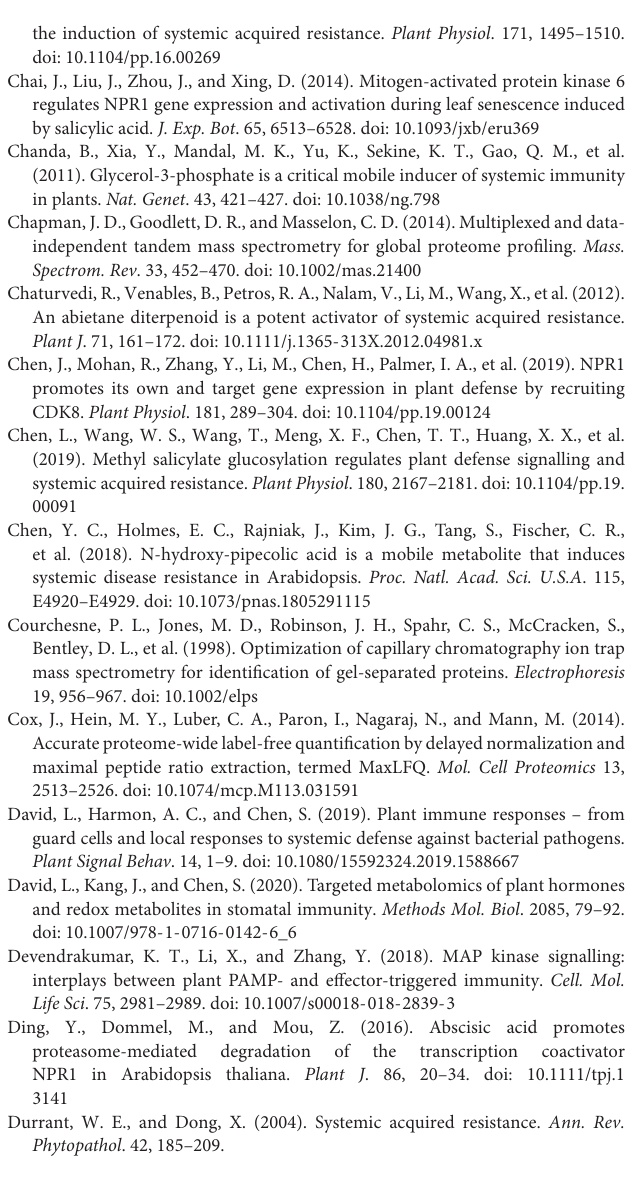
Supplementary Table 10 | Differentially phosphorylated proteins related to SA and ABA signaling pathway. Supplementary Table 11 | Differentially phosphorylated ABC transporter family proteins. Supplementary Table 12 | Primers used for RT-qPCR. Supplementary Data 1 | List of representative MS2